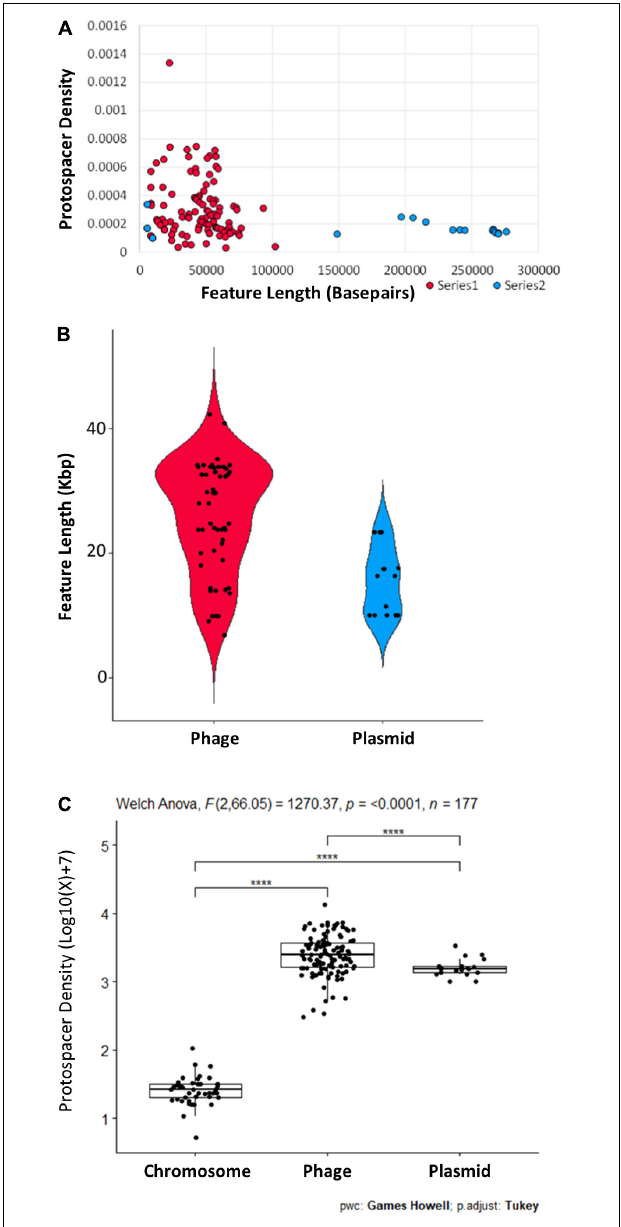
FIGURE 6 | Phage and plasmids vary in length and protospacer density. (A) Protospacer density in phage ( n = 115) and plasmids ( n = 19) from 43 closed G1 C. botulinum and C. sporogenes genomes plotted relative to size in base pairs. (B) Range in length of phage ( n = 55) and plasmids ( n = 14) with no protospacer matches. (C) Phage and plasmids are significantly enriched in protospacers relative to the chromosome. Additional data and parameters are provided in Supplementary File 8 . **** indicate statistical